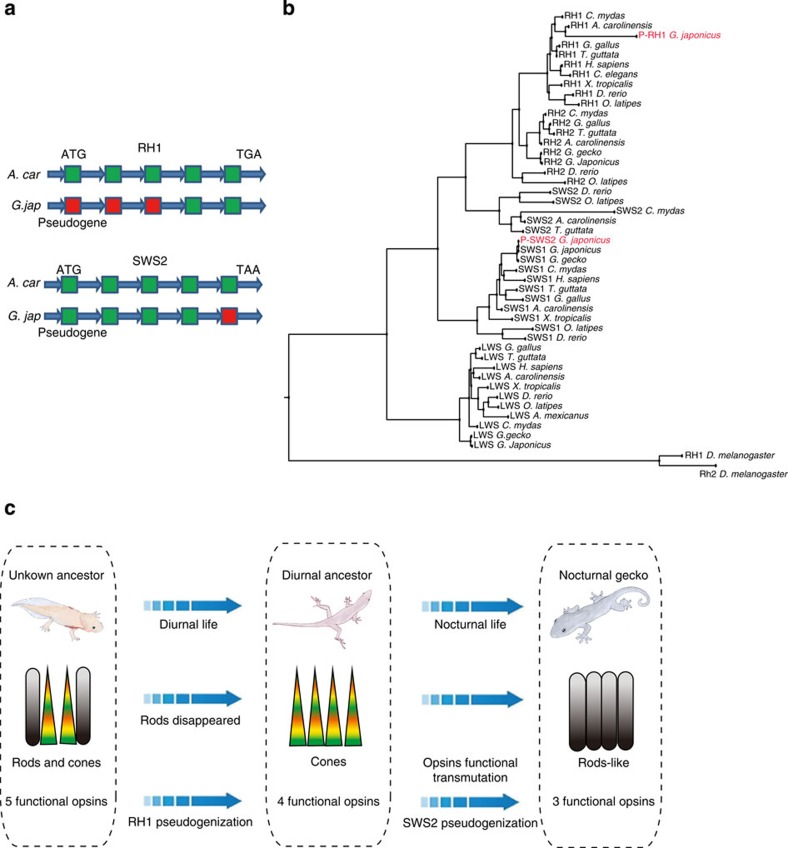
Opsins genes in the G. japonicus genome.(a) Analysis of RH1 and SWS2 pseudogenes showed mutations in both initiation and termination codons. In addition, the exons of RH1 and SWS2 in G. japonicus were lost, incomplete or shifted in comparison with those in A. carolinensis. The green boxes indicate exons with similarity to those in A. carolinensis. The red boxes represent the lost exons. (b) Phylogenetic analysis of opsin genes from Drosophila melanogaster, Danio rerio, Oryzias latipes, Xenopus tropicalis, Chelonia mydas, Gallus gallus, Taeniopygia guttata, Anolis carolinensis, Gekko gecko and Homo sapiens. The pseudogenes in G. japonicus (P-RH1 and P-SWS2) are indicated in red. (c) Opsin evolution in G. japonicus at genomic level agrees with observed evolutionary variation of retinal cell type and visual sense.